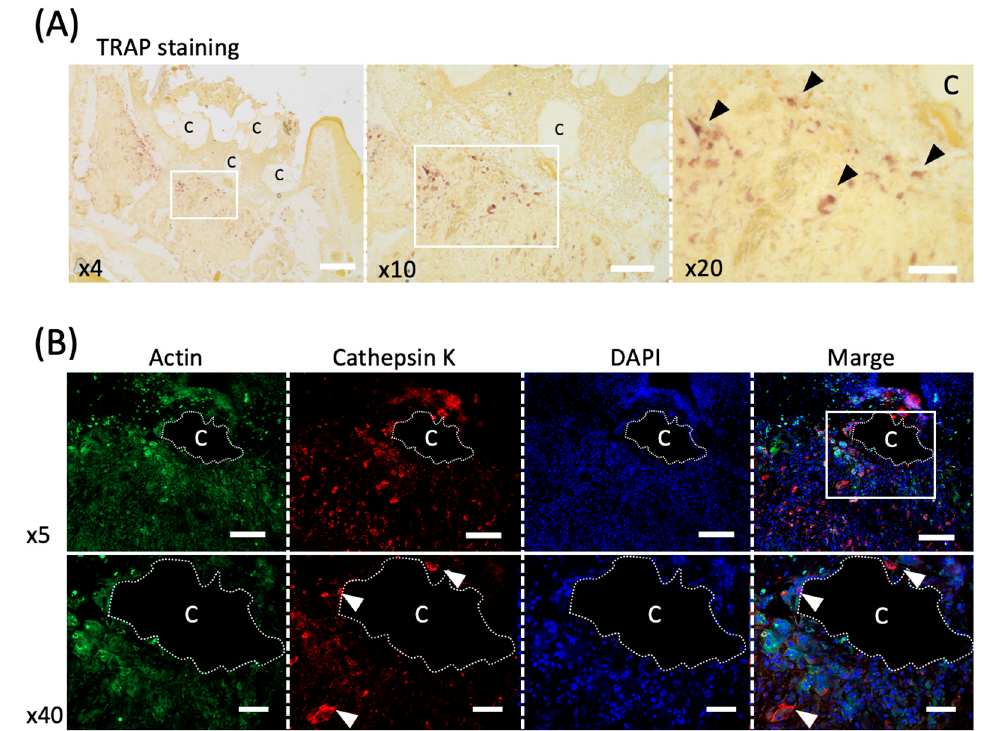
Figure 4. Evaluation of the osteoclast activity in an in vivo study. ( A ) TRAP staining of the healing socket 5 days after tooth extraction. The black arrowheads indicate osteoclasts. C; Cytrans. Bars = 300 μ m (×4), 200 μ m (×10), 100 μ m (×20). ( B ) Immunofluorescence staining of cathepsin K (red) , F-actin (green) and DAPI (nuclei, blue) in upper panel (×5) and lower panel (×40). White arrowheads indicate multinucl e ated osteoclasts co-localized with cathepsin K and DAPI. C; Cytrans (white dots area). Bars = 500 μ m (×5), 100 μ m (×40).